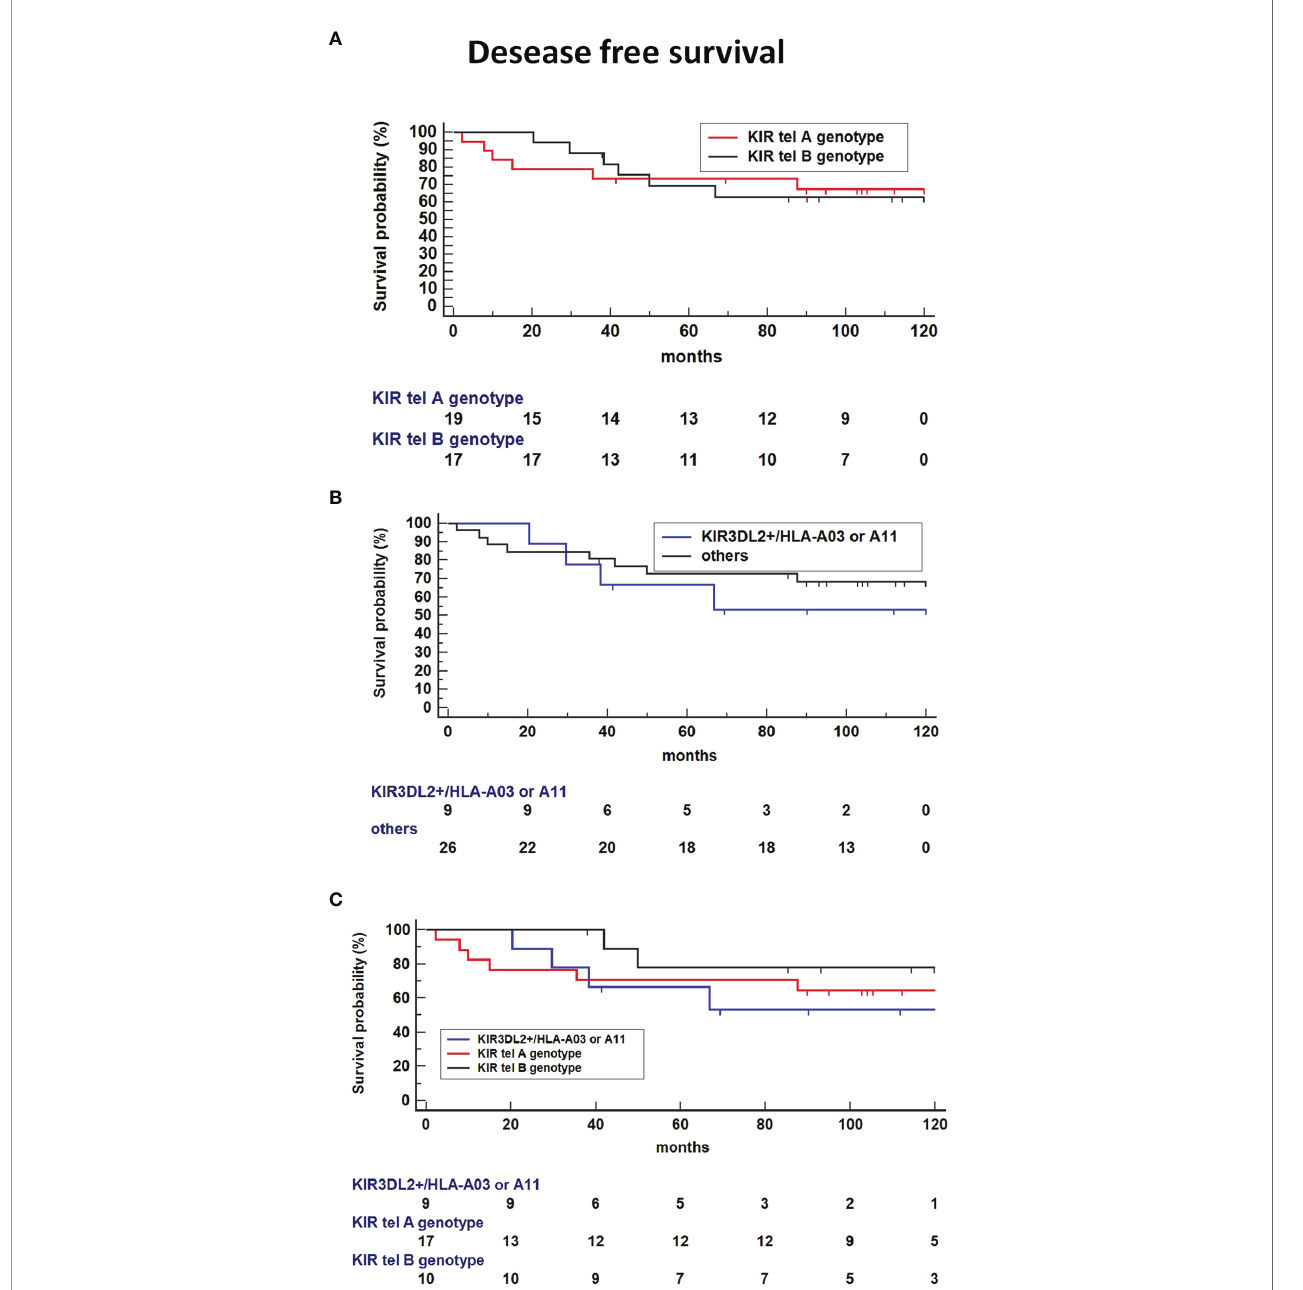
FIGURE 6 | Kaplan-Meier survival analysis showed improved Disease-free survival (DFS) time for tel B genotype carriers compared to tel A carriers (A) and absence of the functional tel KIR3DL2+/HLA-A*03 or A*11 combinations compared to other KIR/HLA combinations (B) . (C) Co-presence of Tel B genotype and KIR3DL2+/ HLA-A*03 or A*11 genes reduce DFS compared to Tel-B lacking the KIR3DL2+/HLA-A*03 or A*11 combinations (HR: 3.85, 95%CI 0.72-20.5, p =